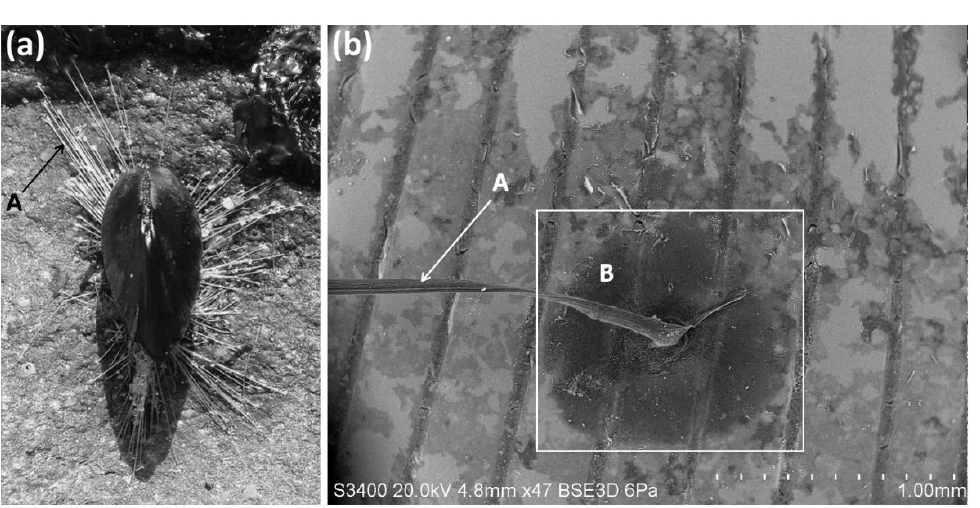
Figure 3. ( a ) An example of an individual marine mussel (centre, Mytilus sp. ) attached and anchored to a substrate with surrounding (byssus) threads (arrowed, A, top left), and ( b ) a backscattered electron micrograph showing an individual byssus thread in detail (arrowed, A: scale bar = 1 mm) and the accompanying adhesive attachment pad (dark approximately circular region within rectangle, B). In this case, the byssus thread is attached to another bivalve species with a surface texture (the vertical lines within image ( b )). The extent of the adhesive spreading of the attachment pad is of interest, and the strength of attachment of mussel species makes them particularly prolific biofouling organisms in aquatic environments worldwide. Image ( a ) by Brocken Inaglory from Wikimedia Commons, licensed under CC BY-SA 3.0.